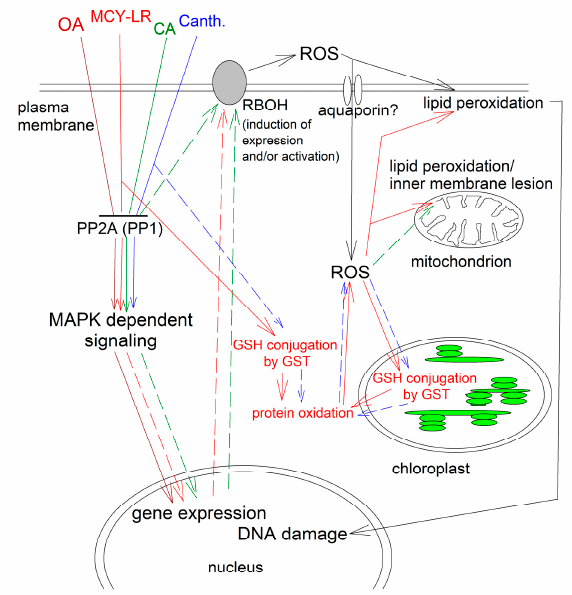
Figure 1. ROS-related targets of PP2A inhibitors in plants. Clear lines / arrows show mechanisms that are already elucidated, while dashed lines / arrows show mechanisms for which some evidence exists, but further research is needed for clarifying. As can be seen, all inhibitors activate MAPK cascades by PP2A inhibition and this might be a key step in the production of ROS via RBOH. On the other hand, a decrease in reduced glutathione (GSH) pool due to the formation of GSH-MCY-LR (or cantharidin) conjugates leads to the elevation of ROS levels in a PP2A independent pathway. For MCY-LR, there are three possible mechanisms of oxidative stress induction (see text) of which mechanisms 1 and 3 that have been proven for plants are presented here. Lipid peroxidation and protein oxidation can originate from both mechanisms as shown in the Figure, thus a clear separation of these mechanisms is di ffi cult. It was not our scope to show here the uptake mechanisms of inhibitors by plasma membrane and endomembranes. GSH: reduced glutathione; MCY-LR: microcystin-LR; CA: calyculin A; OA: okadaic acid. The e ff ects of di ff erent inhibitors are shown as red: MCY-LR; green: CA; blue: cantharidin; brown: